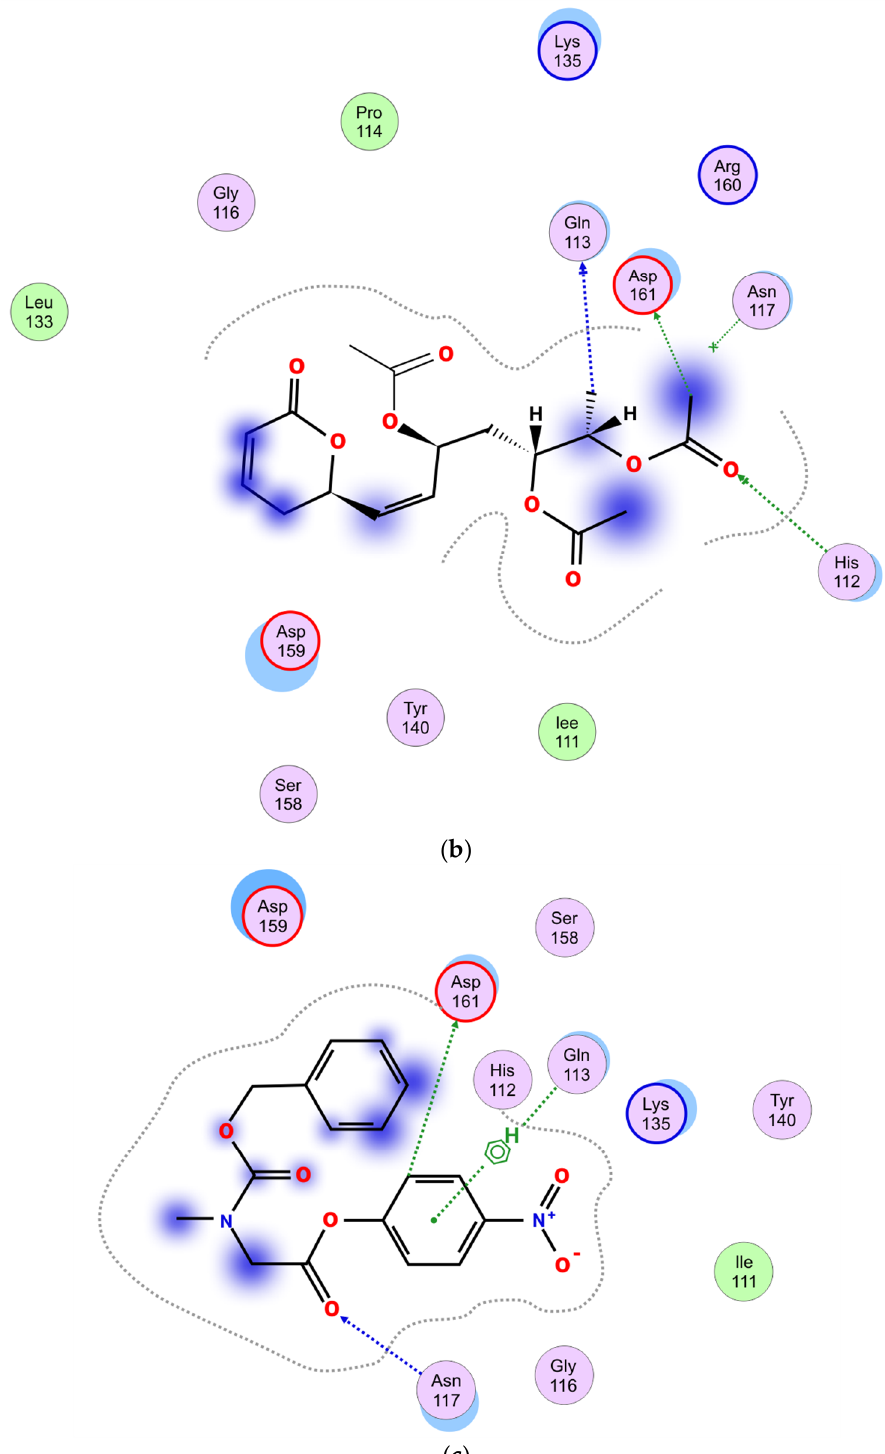
Figure 9. ( a ) Comparison of the binding position of hyptolide and substrate on the binding site of Pk-ClpP from the docking simulation. ( b ) The 2D map of the molecular interaction between Pk-ClpP and hyptolide. ( c ) The 2D map of the molecular interaction between Pk-ClpP and the substrate. Amino acids in blue and red round borders refer to basic and acid residues in contact. Exposure regions in the ligand are indicated by blue contour.